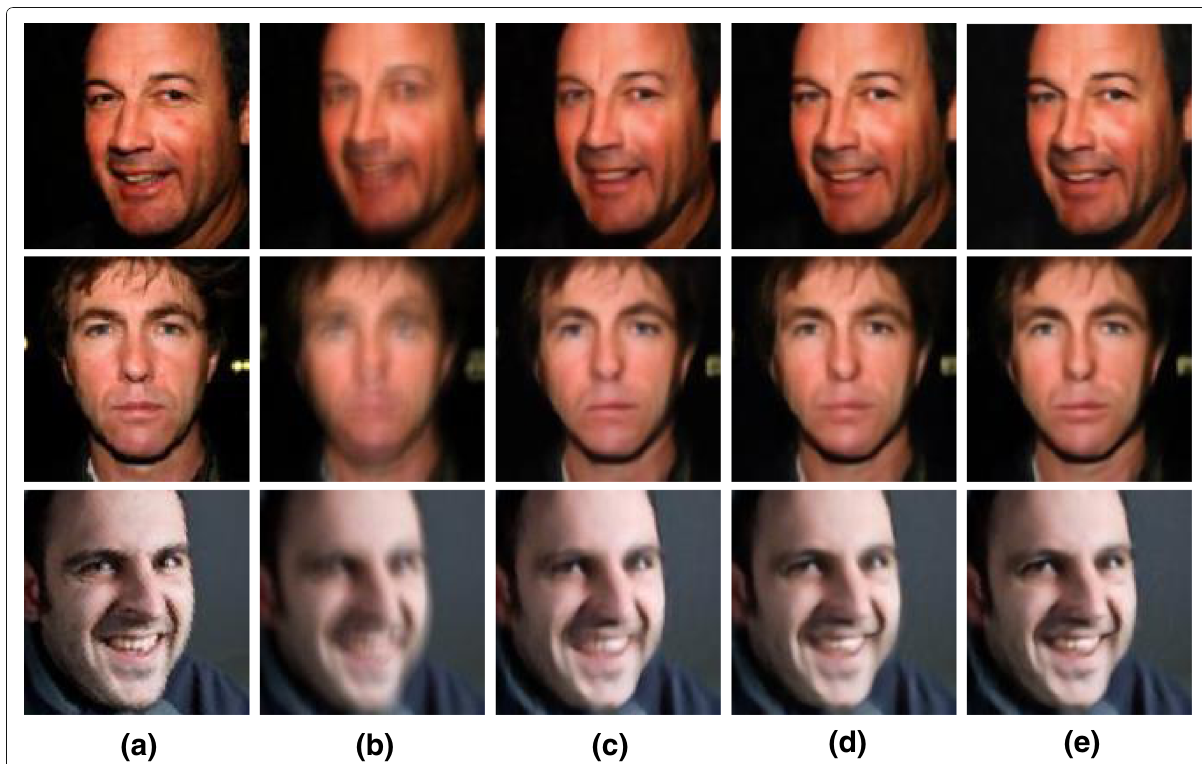
Fig. 5 Effects of additional losses. a Ground truth images. b Blurred images. c Deblurred results (content loss). d Deblurred results (content loss + perceptual loss). e Deblurred results (content loss + perceptual loss + adversarial loss)